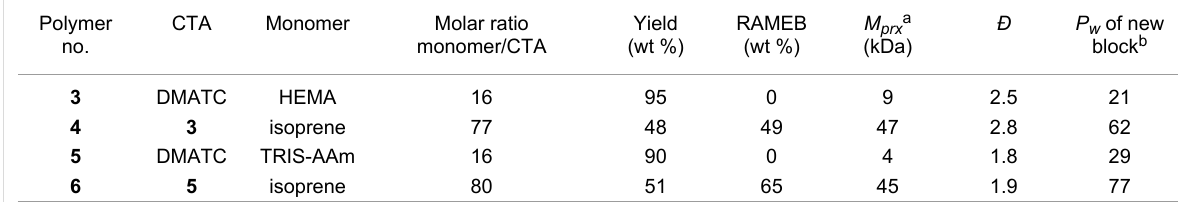
Table 2: Yields, RAMEB content and weight average molar masses ( M prx ) and degrees of polymerization ( P w ) of the polymers obtained by RAFT po- lymerization. Polymer